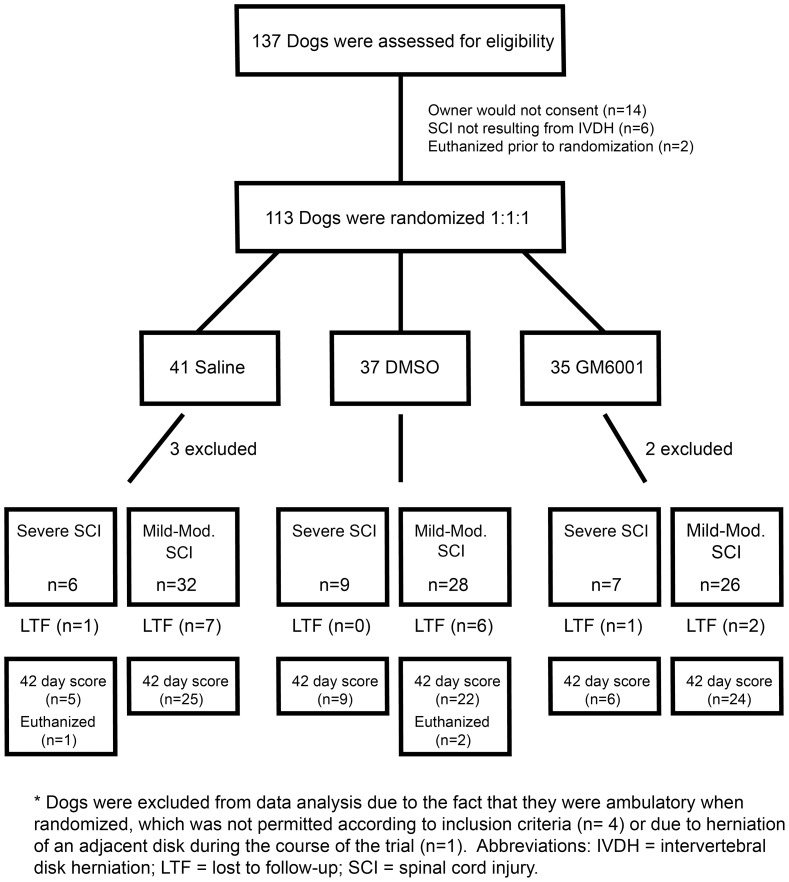
Consolidated Standards of Reporting Trials (CONSORT) Diagram.Flow diagram depicting progress through different phases of the clinical trial including enrollment, group allocation, and follow-up.